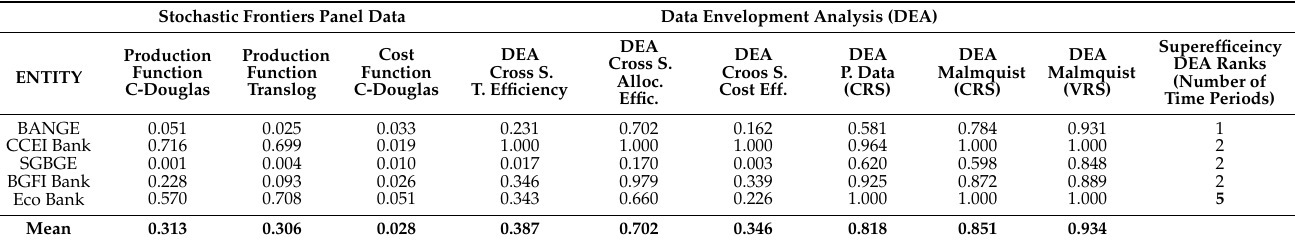
Table 5. Efficiency of the Financial Subsector of